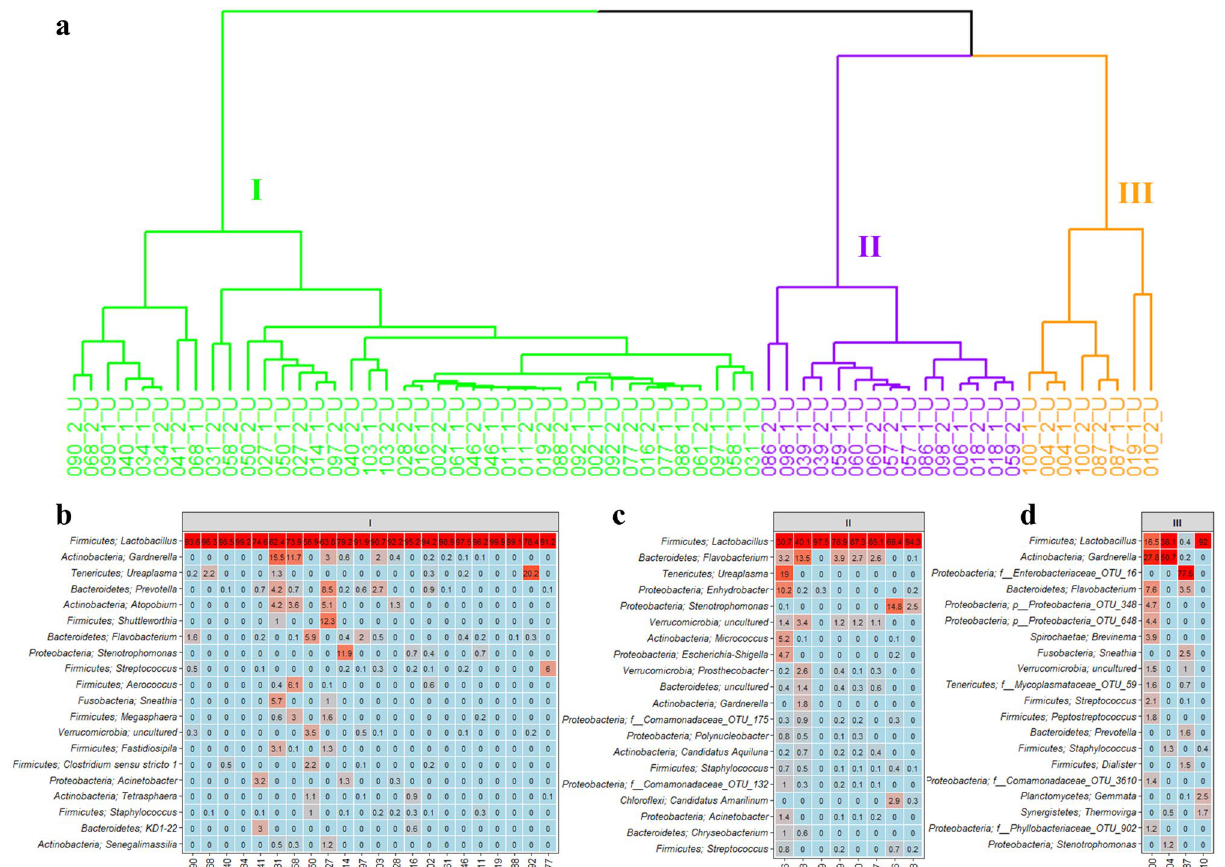
Figure 3. The bacterial composition in urine samples from premenopausal women. ( a ) Dendrogram obtained with hierarchical clustering of OTU diversity in samples. Three urotypes were identified, with green, purple and orange branches representing urotype I, II, and III respectively. ( b – d ) Heatmaps showing the 20 most abundant bacterial genera in the three urotypes, I, II and III. The premenopausal donors 2, 4, and 6 were not placed in any clusters by the unsupervised clustering algorithm